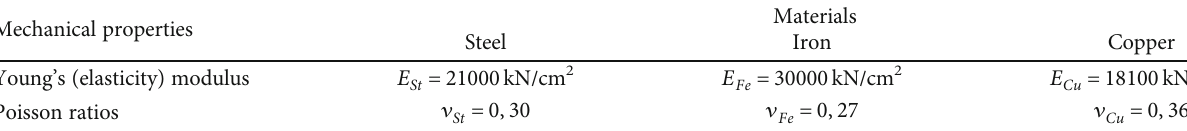
Table 2: The u h solutions obtained by using the bisection method in the system whose hard clamping condition is given at its borders, with the ~ c length values corresponding to these.